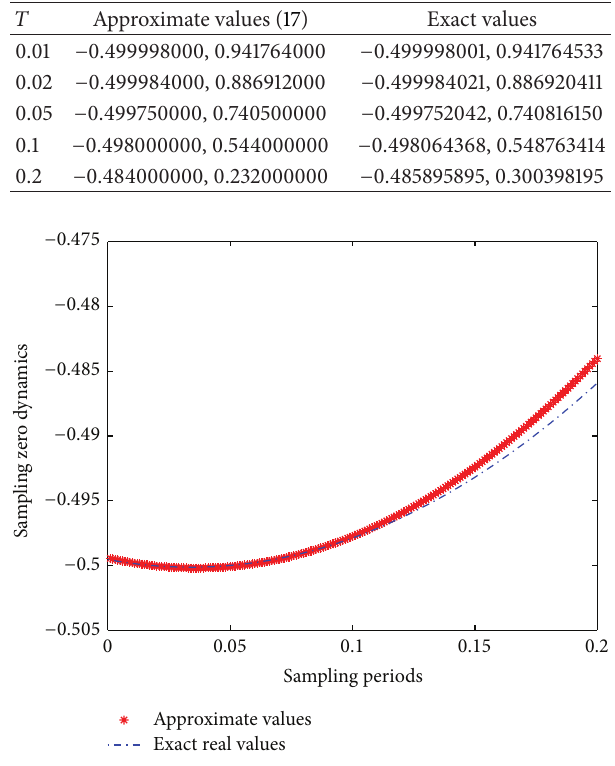
Figure 1: Sampling zero dynamics of the discrete-time model with time delay and relative degree two.